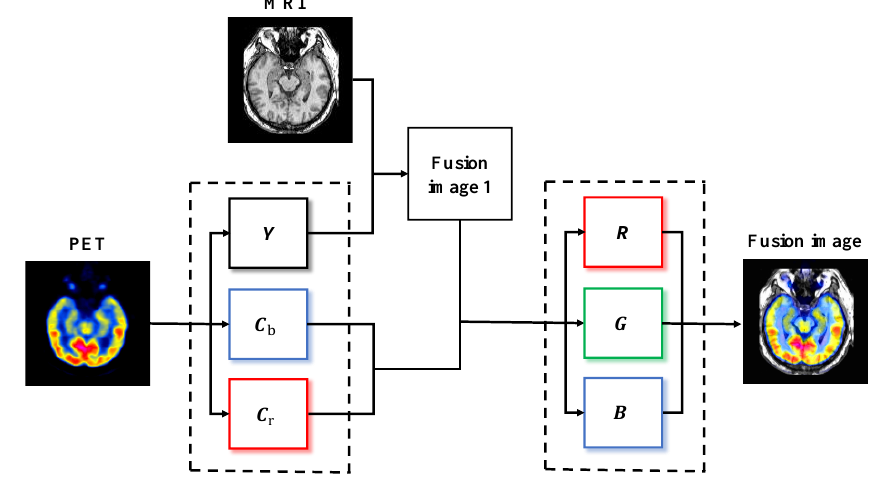
Figure 7. The fusion of PET and MRI images.